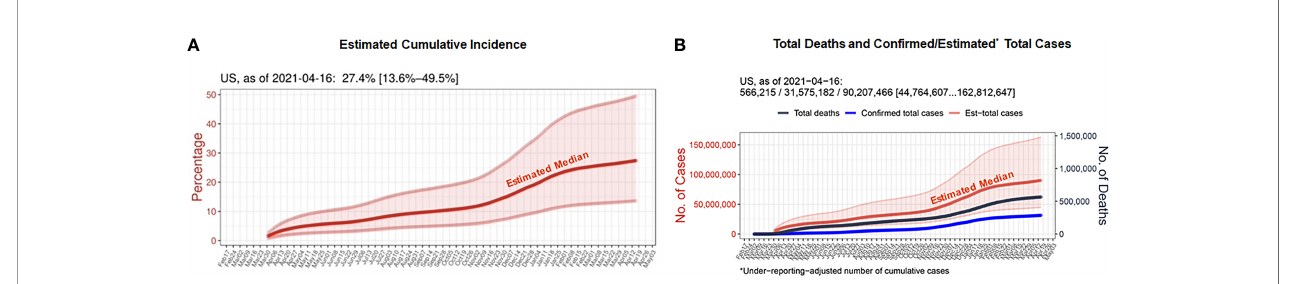
FIGURE 1 | (A) Estimates of cumulative incidence rates for the period until April 16, 2021, for the 50 U.S. states. (B) Seven-day rolling-averaged counts of daily con fi rmed total cases and deaths until April 16, 2021, for the U.S. For this computational study, the COVID Tracking project provided the U.S. dataset (20) and the Center for Systems Science and Engineering (CSSE) repository at Johns Hopkins University remained as a source of con fi rmed cases and deaths for countries (21). The actual number of infections across countries and regions were inferred in terms of the Infection-Fatality-Rate (IFR), since it is one of the key epidemiological parameters that afforded us a clue to fi ll the gap between con fi rmed and actual infections, under the assumption that the number of undocumented deaths is negligible (14). While the IFR is subjected to fl uctuations depending on age structure of population, timeline, the current estimation uses a consensus and previously established estimate of 0.66% IFR that encompass a wide band of uncertainty (0.39% – 1.33%, 95%-con fi dence interval) among all the PCR-con fi rmed infections including asymptomatic cases (22). It is worth noting that considering the estimate ’ s large estimation uncertainty, the con fi dence interval is expected to cover the true IFRs of most countries and U.S. states and our